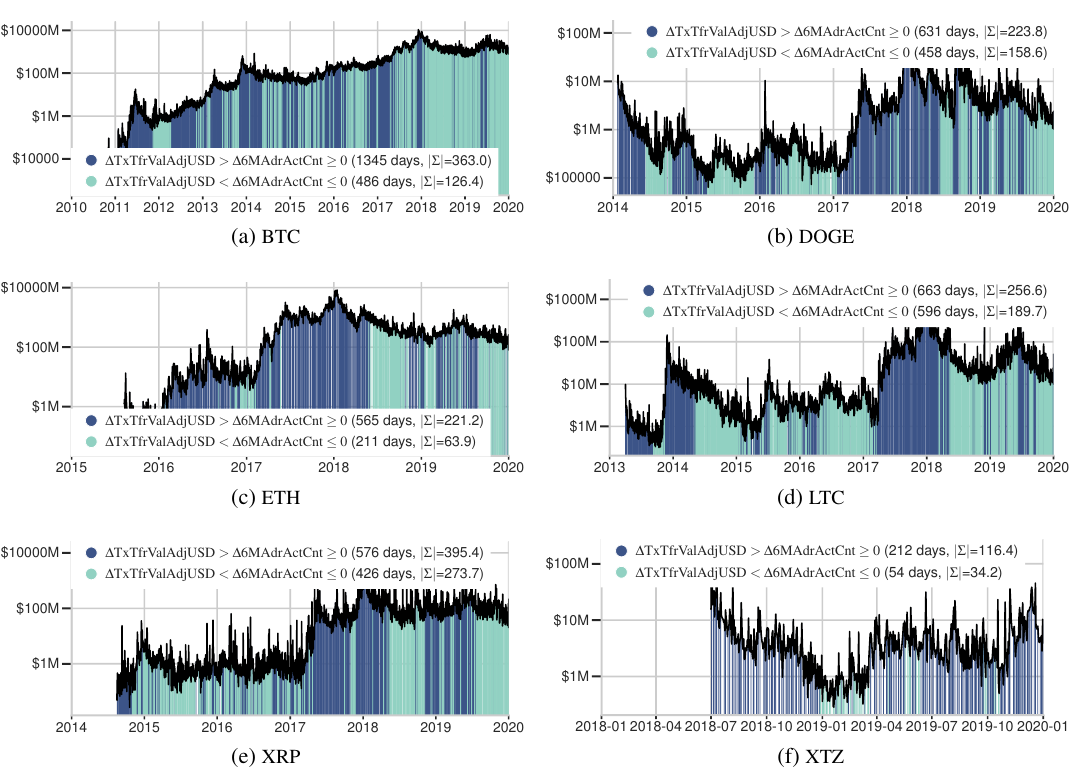
Fig. 4. Network effect observations and distribution (blue: positive NFX, green: reverse NFX, white: no NFX); userbase measured by trailing 6 month addresses, value measured by transaction